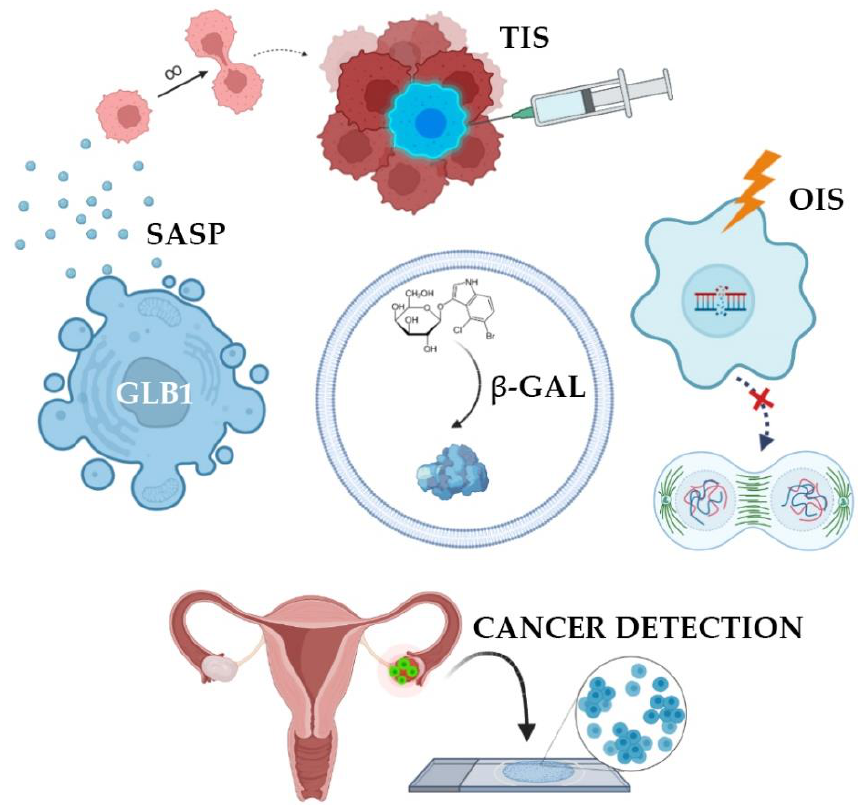
Figure 2. Clinical applications of SA- β -gal detection. SA- β -gal activity is the result of overexpression of GLB1 gene. Normally, oncogene-induced senescence (OIS) prevents cells from becoming tumors.